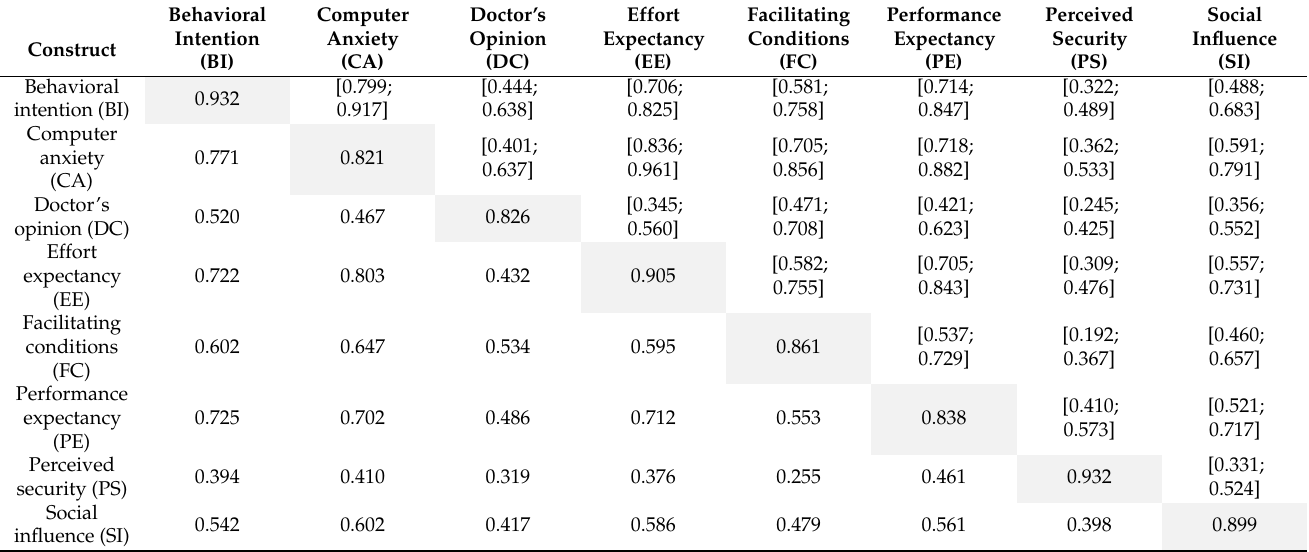
Table A2. Discriminant validity measurement.